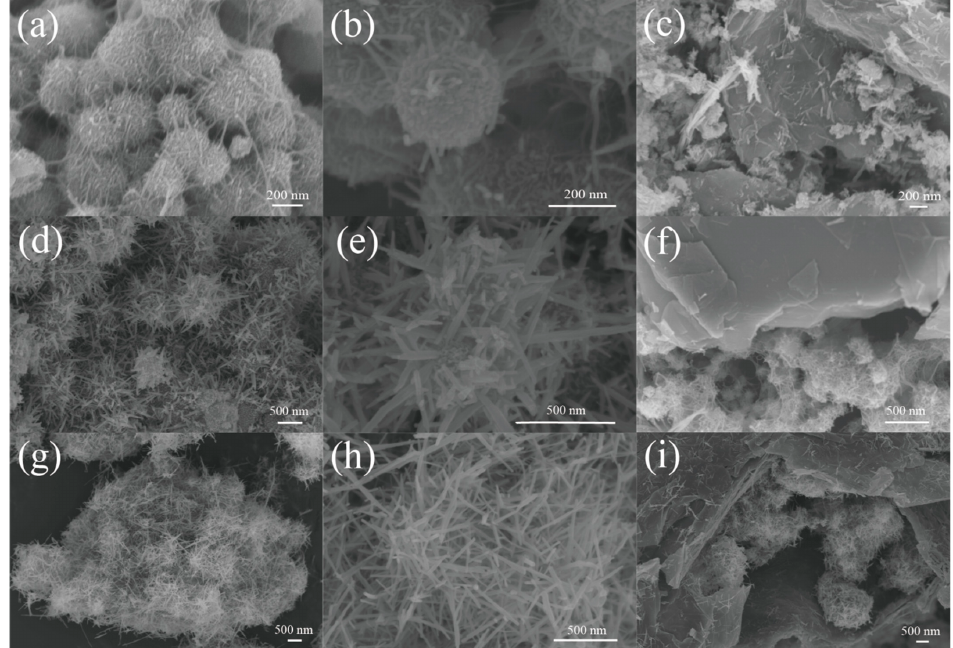
Figure 2. ( a ) SEM image of the Si@MnO 2 -20°C composite. ( b ) Enlarged view of the SEM image of the Si@MnO 2 -20°C composite. ( c ) SEM image of the Si@MnO 2 @rGO-20°C composite. ( d ) SEM image of the Si@MnO 2 -50°C composite. ( e ) Enlarged view of the SEM image of the Si@MnO 2 -50°C compo- of the Si@MnO 2 -20 ◦ C composite. ( c ) SEM image of the Si@MnO 2 @rGO-20 ◦ C composite. ( d ) SEM site. ( f ) SEM image of the Si@MnO 2 @rGO-50°C composite. ( g ) SEM image of the Si@MnO 2 -160°C composite. ( h ) Enlarged view of the SEM image of the Si@MnO 2 -160°C composite. ( i ) SEM image of the Si@MnO 2 @rGO-160°C composite. 160 ◦ C composite. ( h ) Enlarged view of the SEM image of the Si@MnO 2 -160 ◦ C composite. ( i ) SEM image of the Si@MnO 2 @rGO-160 ◦ C